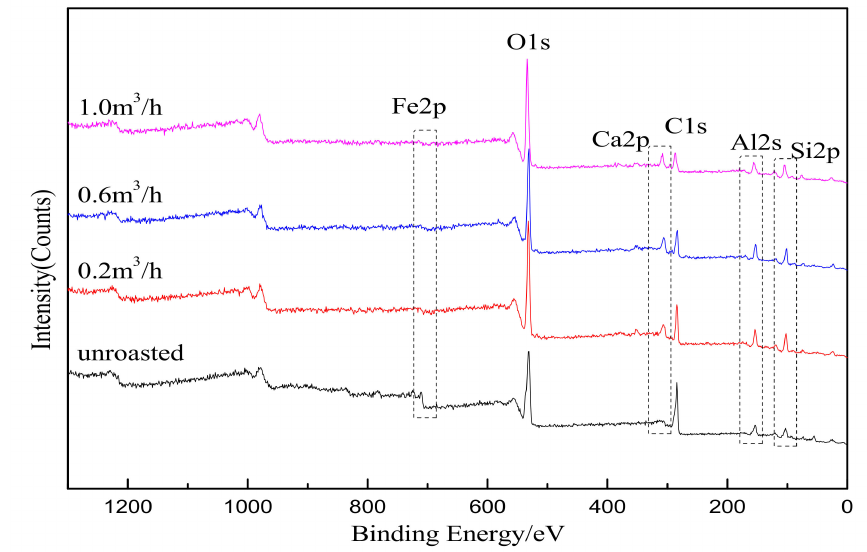
Figure 5. XPS total spectrum of calcine at different ventilatory